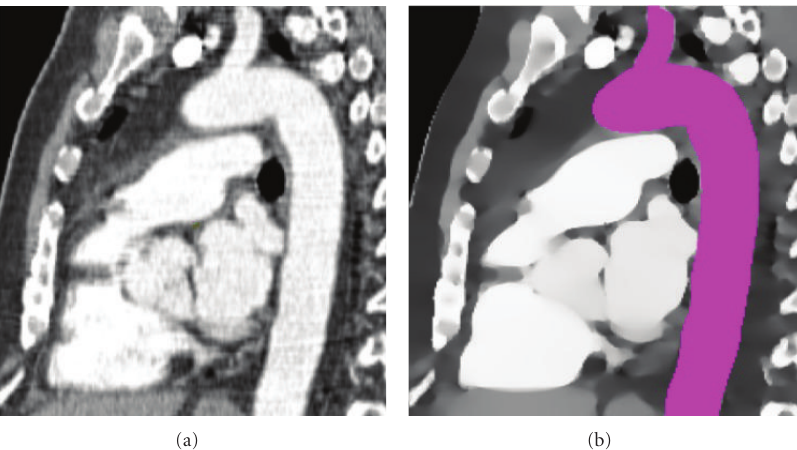
Figure 12: (a) Two-dimensional sagital slice through computer tomography (CT) data of thorax with vascular contrast used in preliminary testing of our algorithm. (b) Mean of means μ μ ( x ) image showing reduced noise and sharp boundaries, automated segmentation of aorta highlighted (purple) created from a single-seed point.